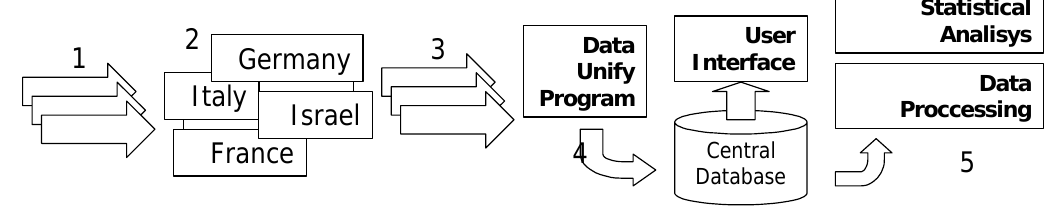
FIGURE 6 . A schematic flow of the data collection and analysis